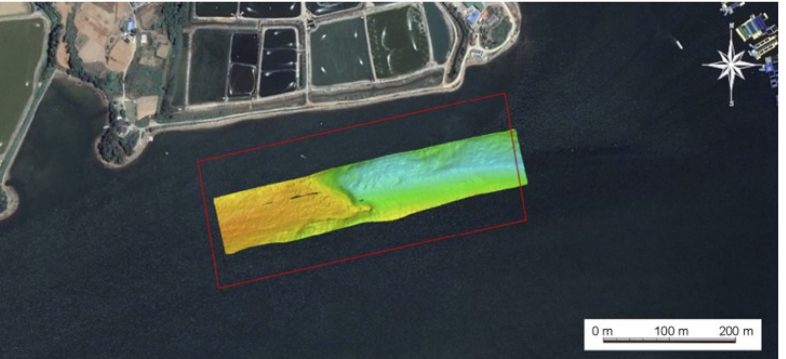
Figure 4. Surveying range of the multibeam echo sounder at the site ( (cid:3) : the site, Google